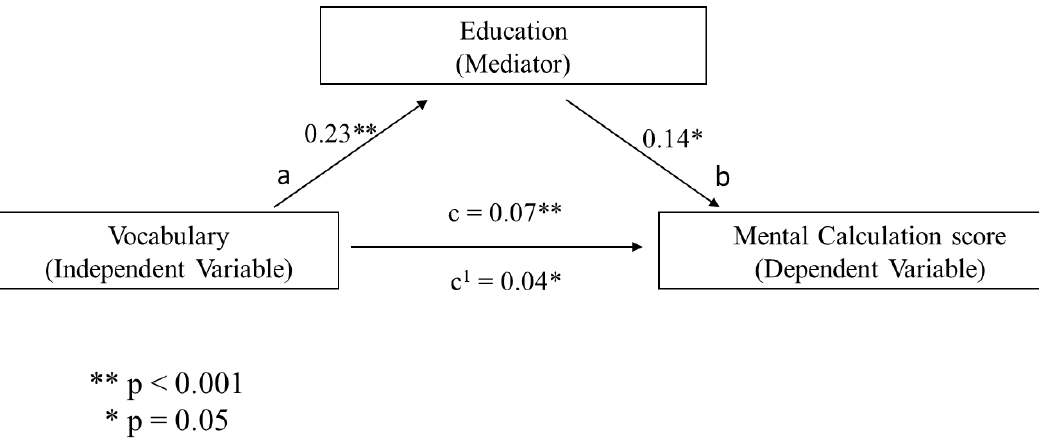
Figure 3. The predicted mediational patterns for Mental Calculation using vocabulary knowledge as the independent variable and educational attainment as mediator.